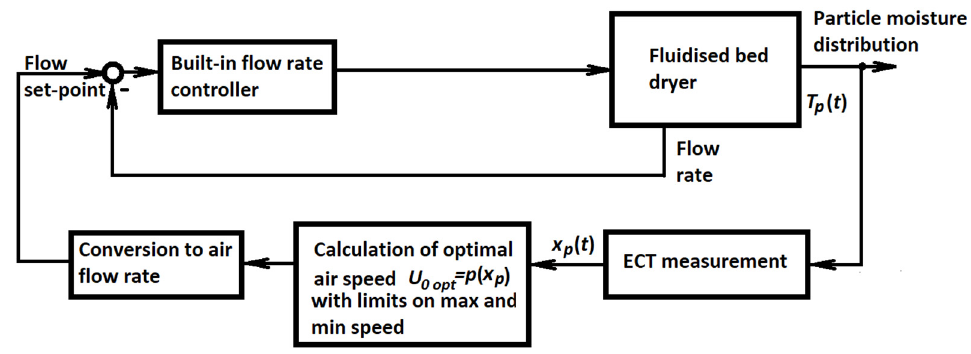
Figure 6. Schematic structure of the fluidized bed dryer control Figure 6 . Schematic structure of the fluidized bed dryer control system.